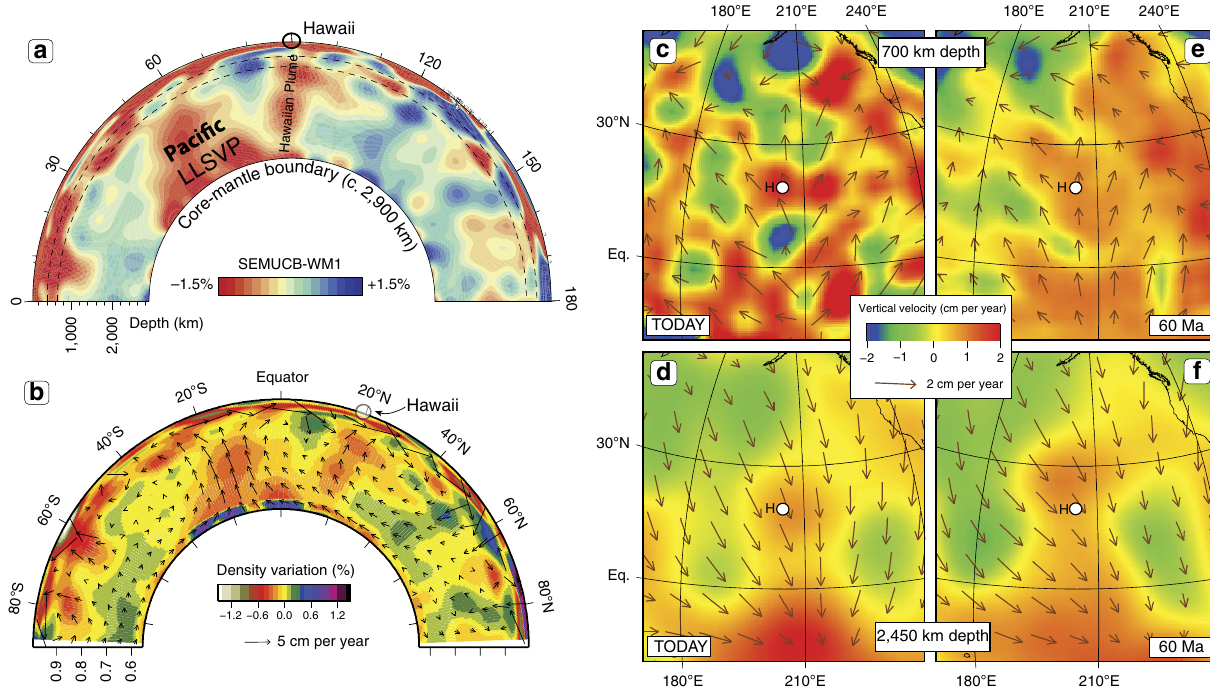
Figure 6 | Imaging the Hawaiian Plume and geodynamic modelling. ( a ) North-south vertical slice of the SEMUCB-WM1 43 mantle tomography model through the Pacific LLSVP (Large Low Shear-wave Velocity Province 31,32 ) and the Hawaiian Plume. Axis numbers indicate arc degrees from the start of the profile. ( b ) Cross-section from the South Pole to the North Pole at 155 (cid:2) W and map views at 700 and 2,450km depth, at times 0Ma (today) and 60Ma ( c – f ). The mantle flow geometry (see Methods) is dominated by southward flow in the mid-to-lower mantle ( d , f ) and northward flow in the uppermost part of the lower mantle ( c , e ) and in the upper mantle. White circles indicate location of Hawaii